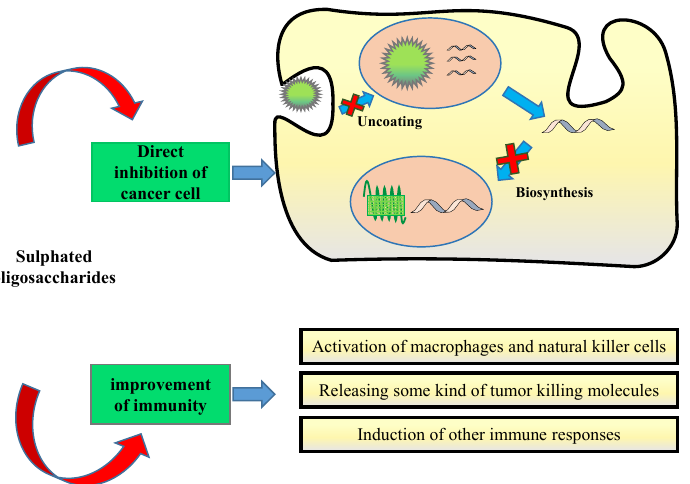
Figure 4. Anticancer activities of FOSs through two common mechanisms: direct and indirect anticancer activities that affect both tumor cells and their surrounding microenvironment.